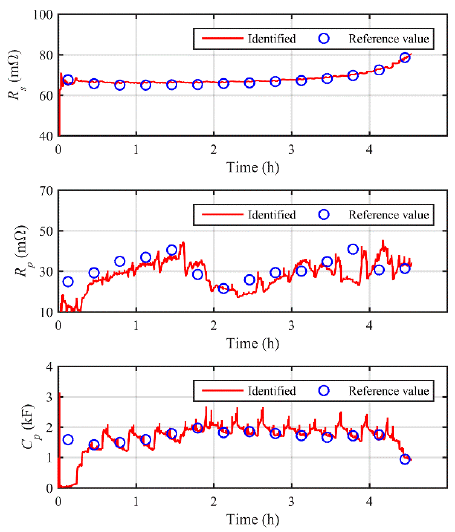
Figure 8. Results of online model parameters identification for the experimental study.